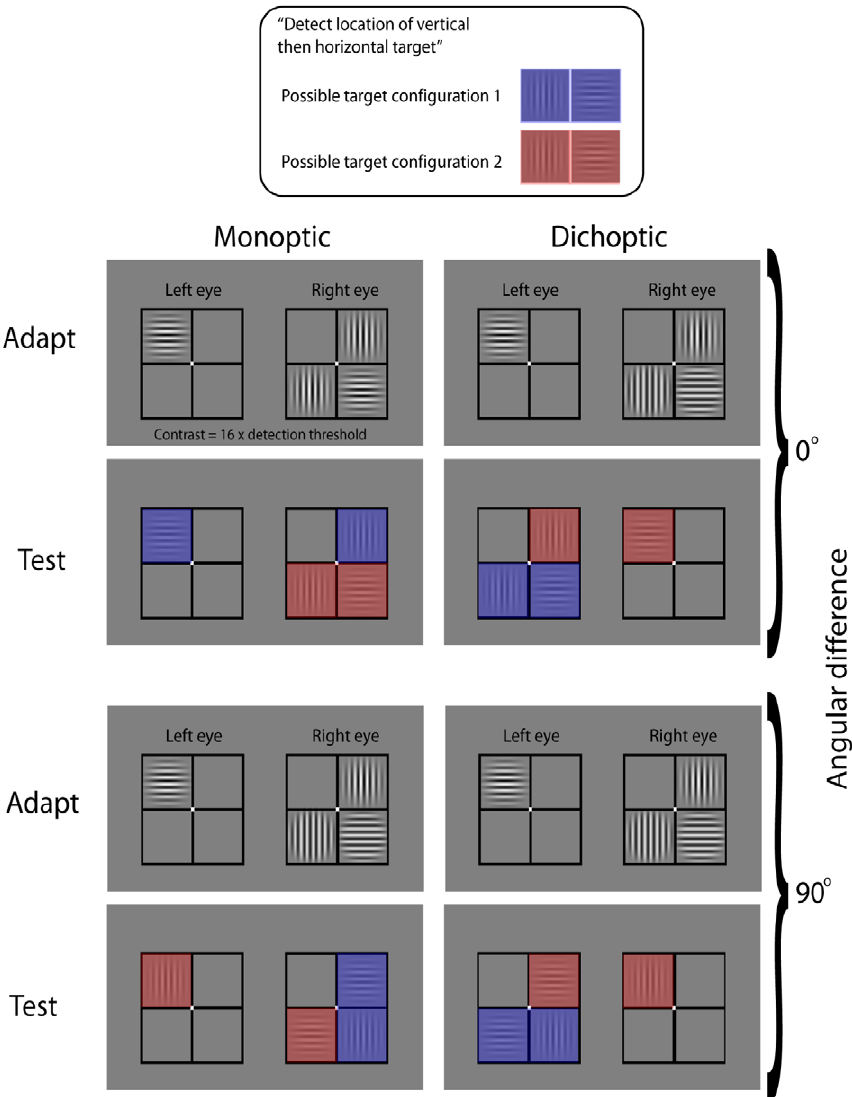
Figure 1. An example of the spatial configuration of adaptor and test stimuli. Four conditions are shown (clockwise from left): monoptic 0 u , dichoptic 0 u , dichoptic 90 u and monoptic 90 u . The figure provides an example of possible adaptor stimuli configurations, and the two possible configurations of target stimuli. to first identify the location of the vertical target, then the location of the horizontal target. The task was a spatial four-alternative forced-choice (4AFC) task with binary orientation identification adapted from [41– 42]. Responses were made using a standard configuration number keypad. Keys 1 and 4 corresponded to locations left of fixation in lower and upper visual fields respectively, with keys 2 and 5 corresponding locations to the right of fixation in lower and upper visual fields respectively. The chance level was 25% for the first response, followed by 31.6% for the second response [41], corresponding to detection rates of 25% on the 21% of trials where the first target was not detected, plus 33% on the 79.4% trials where the first target was detected, and produced an overall chance performance rate of 28% across conditions. Thus our psychometric functions were constrained to have a lower asymptote of 28%, an upper asymptote of 100%, with threshold defined as contrast yielding 64% correct detection perfor- mance.